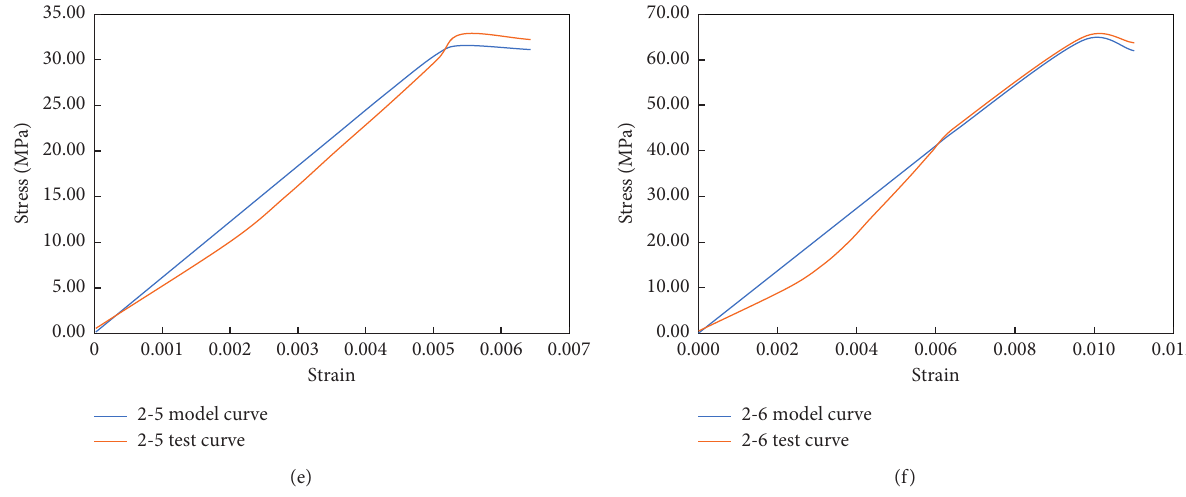
Figure 5: Stress-strain model curve and the test curve of the cracked rock. (a) 2-1. (b) 2-2. (c) 2-3. (d) 2-4. (e) 2-5. (f)